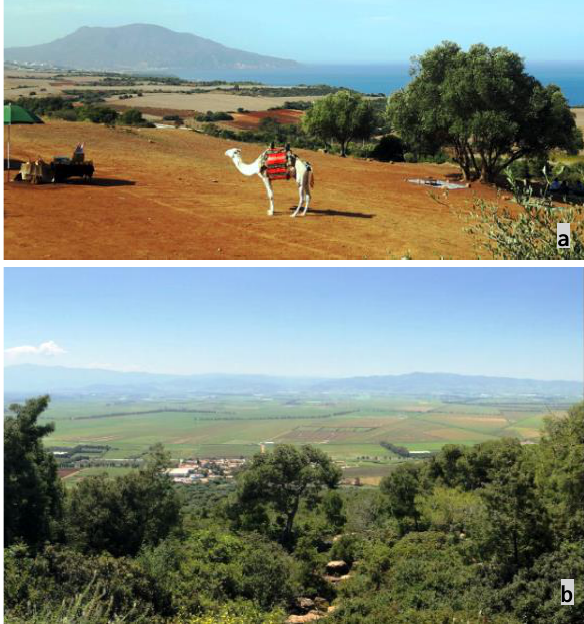
Figure 6. Panoramic views from the site, a. on the sea and Mount Chenoua, b. on the Mitidja plain, the 'plateau Blideen' and the hinterland, © Aoudia.Benali L.,